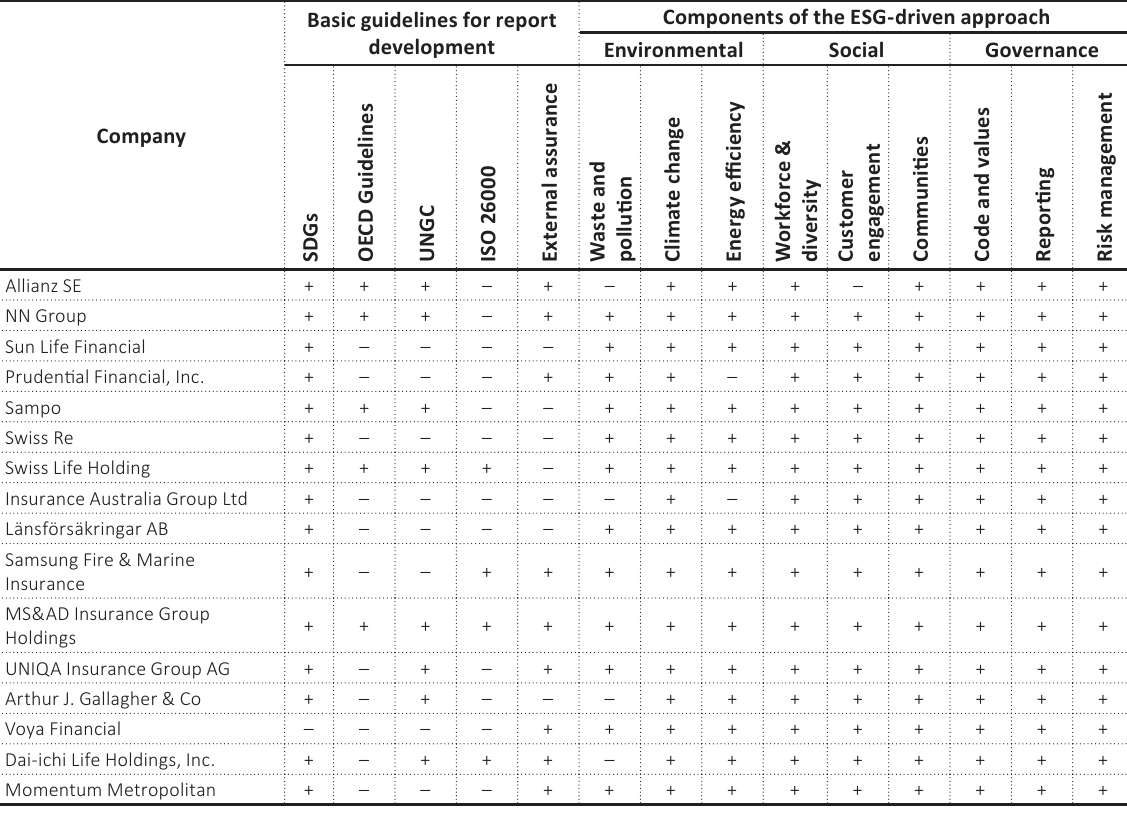
Table 4. Comparison of non-financial reports of insurance companies